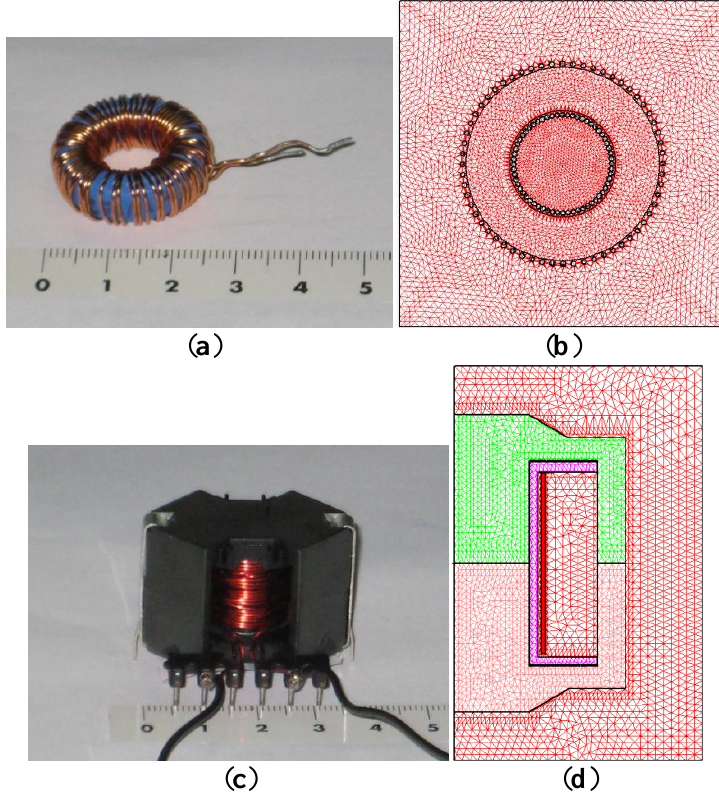
Figure 1. ( a ) Real inductor with a toroidal ferrite core; ( b ) triangular mesh generated by 2D simulations; ( c ) real inductor with an RM (Rectangular Modulus) ferrite core; ( d ) triangular mesh generated by 2D